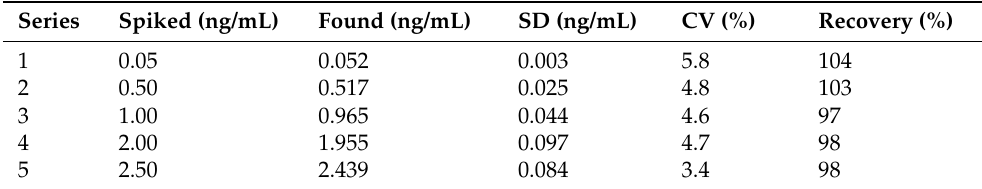
Table 2. Recovery and precision of the developed method.